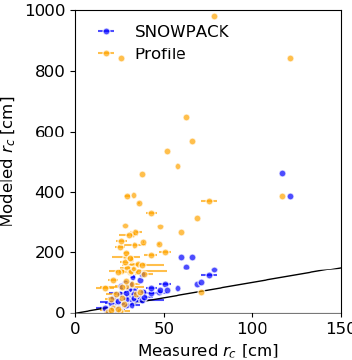
Figure 7. Parameter F opt (Eq. 6) with modeled normalized weak wl times normalized grain size gs wl . The blue line layer density ρ wl ρ ice gs 0 shows a power-law fit for F wl (Eq. 7). The blue area is the 95% confidence interval of the 10-fold cross-validation. and measured r c values (orange dots in Fig. 10) were also